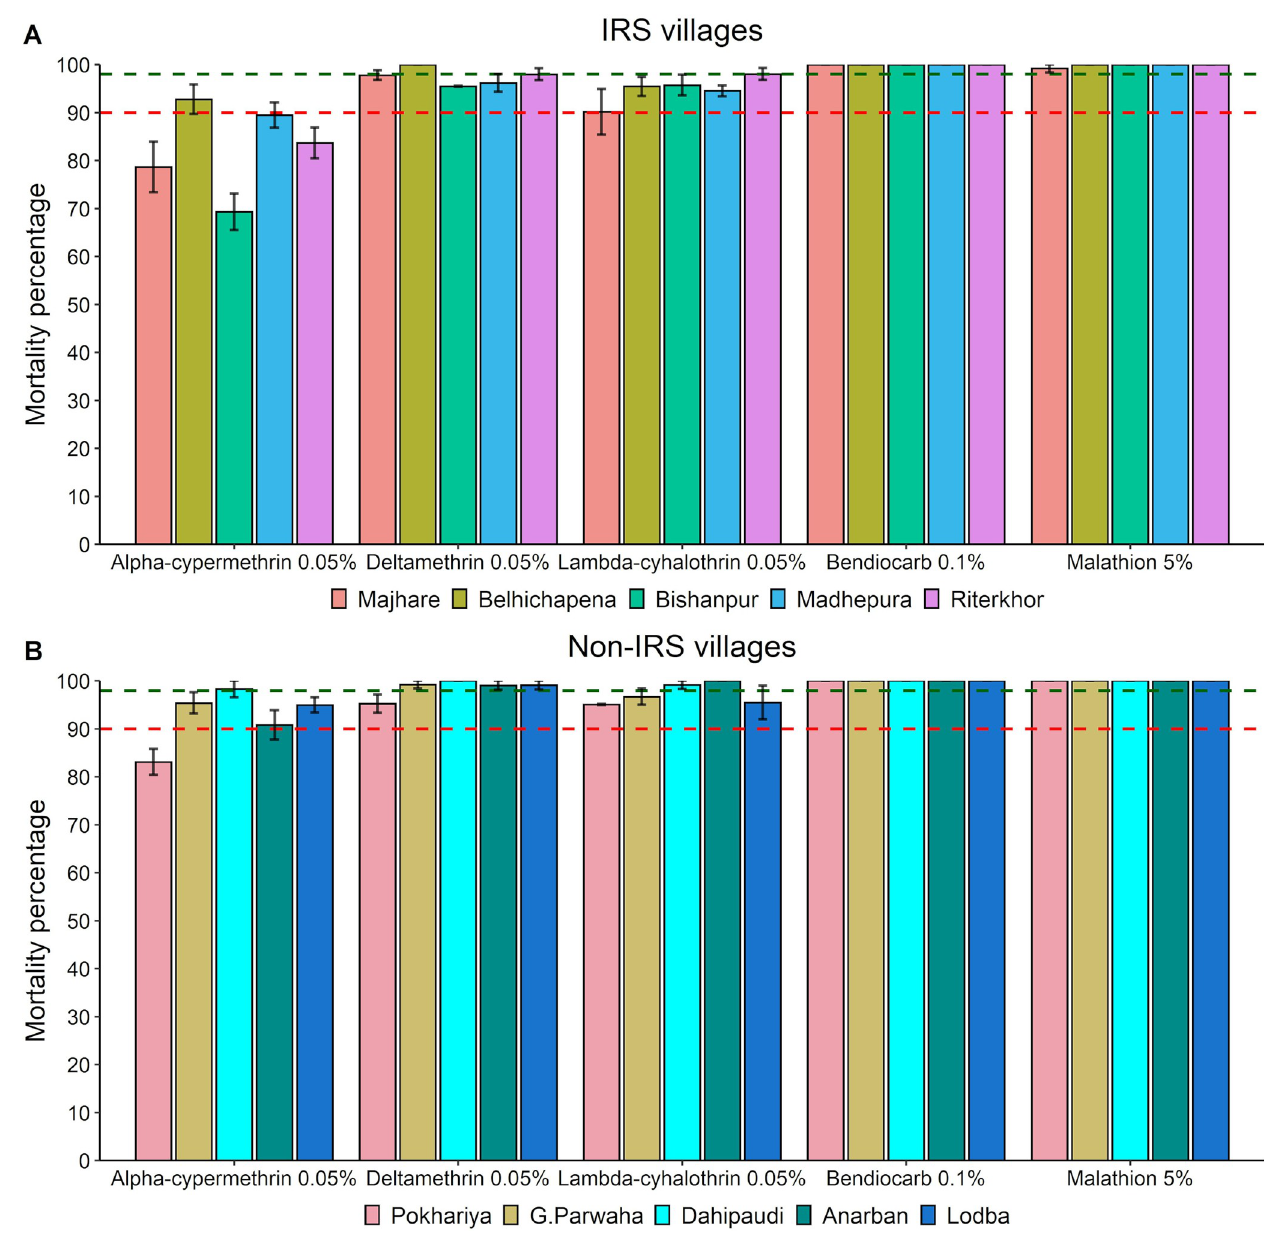
Fig 3. Mean mortality percentage after 24h of holding in the IRS (A) and the non-IRS villages (B). Error bars represent the standard error of the mean. The green-dashed intercept represents the level of 98% mortality; the red dashed intercept represents the level of 90% mortality. https://doi.org/10.1371/journal.pntd.0010304.g003 with mortality rates between 90.77% ± 3.07% to 95.36% ± 2.24%, and susceptible in one village. All villages except one had vector populations susceptible to deltamethrin 0.05%. In three vil- lages, the sand fly populations showed possible resistance to lambda-cyhalothrin 0.05% with mortality rates 95.04% ± 0.09% to 96.69% ± 1.72%, whereas in two others they were suscepti- ble. Like the IRS villages, the sand flies in all non-IRS villages were susceptible to bendiocarb 0.1% and malathion 5%, with a 100% mortality rate.